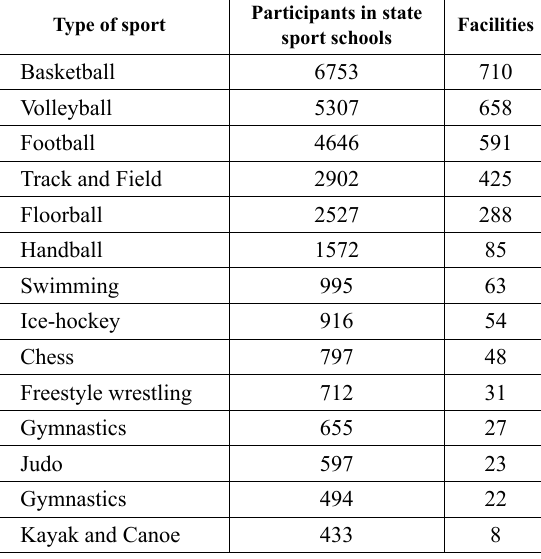
Table 1. The most popular types of sport among youth in Latvia and the available resources of sports